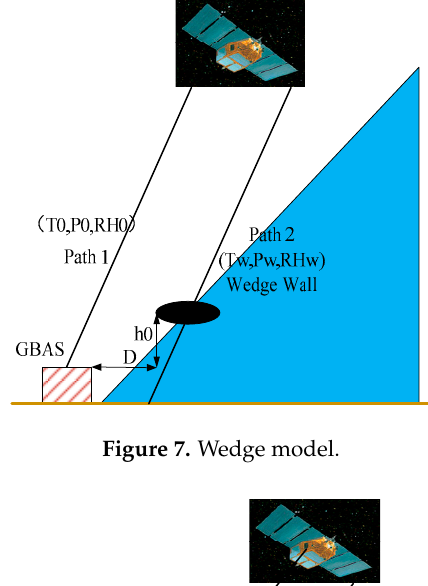
Figure 7. Wedge model.